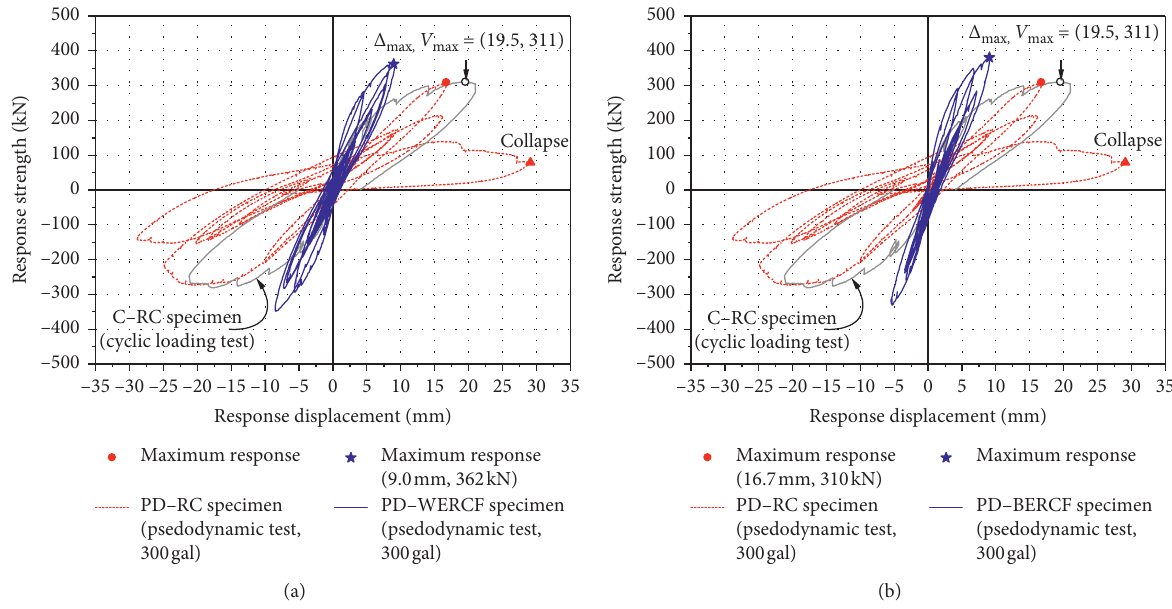
Figure 12: Lateral response load-displacement relationships for specimens strengthened with the ESRCF system during pseudodynamic testing at 300gal. (a) PD-WERCF; (b)